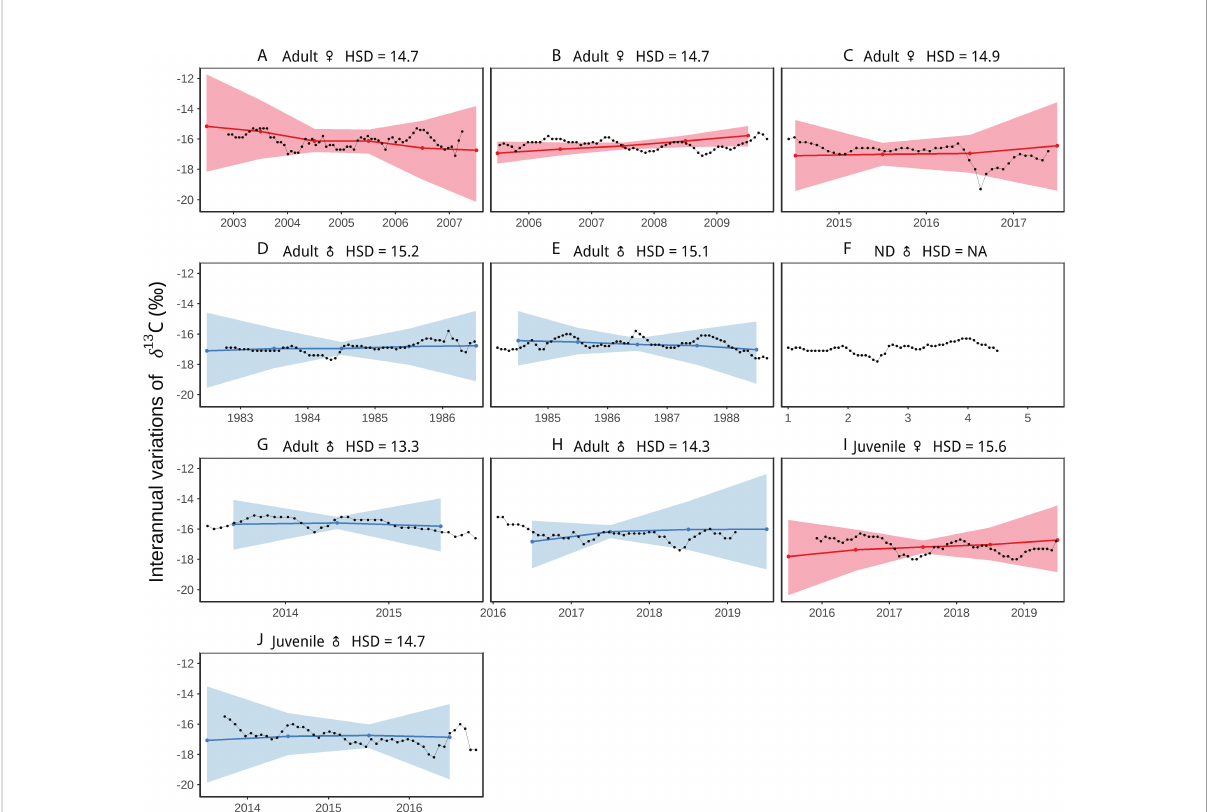
FIGURE 4 Interannual random effects on Suess corrected d 13 C values along nine individual blue whale baleen plates as a function of time. The hyper- standard deviation (HSD) of the random-effect likelihoods is reported for each whale. Colors represent females (red), and males (blue). Colored dots and lines are the medians of the random effects, and colored shaded areas are the 95%-credible intervals. Figure shows whales (A – J) . HSD could not be estimated for whale (F) given the lack of information on stranding date, so the temporal scale corresponds to the number of years re fl ected in the baleen